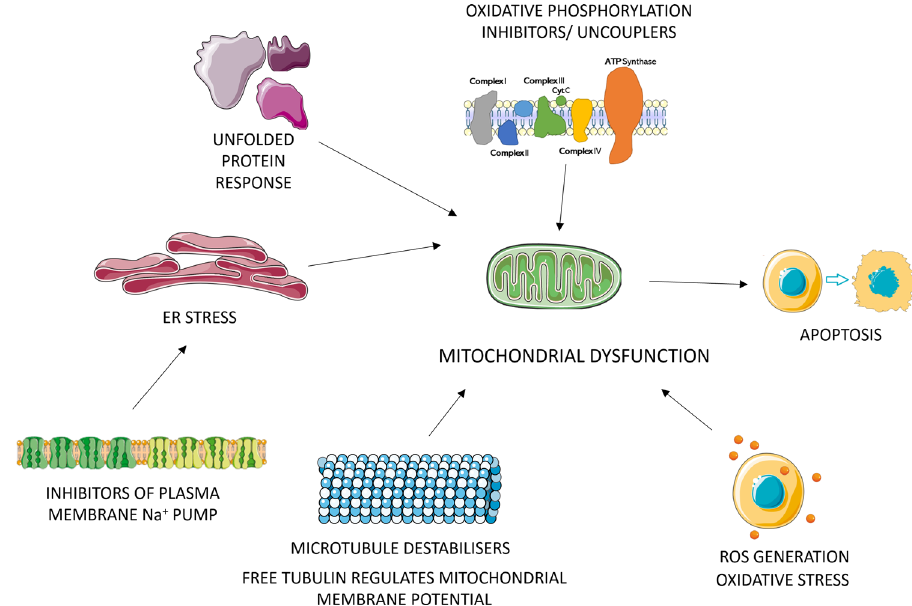
Fig. 1 Some of the major mechanisms of action of mitochondrial toxicants. Toxicants act on multiple pathways to exhibit mitochondrial toxicity, including but not limited to, unfolded protein response, inhibition of mitochondrial respiratory chain or uncoupling of oxidative phosphorylation, oxidative stress from responses including generation of reactive oxygen species (ROS), microtubule disruption and ER stress from various responses including inhibition of Na + pumps etc. The Figure was partly generated using Servier Medical Art, provided by Servier, licensed under a Creative Commons Attribution 3.0 unported